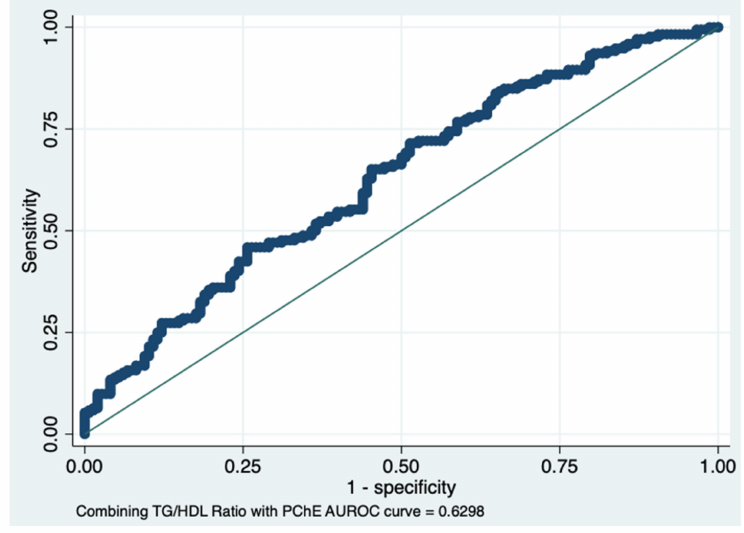
Figure 6. ROC area combining the triglycerides/HDL ratio with pseudocholinesterase levels. A new parameter generated by combining the TG/HDL ratio with pseudocholinesterase levels showed an improvement in the discrimination power of the presence of